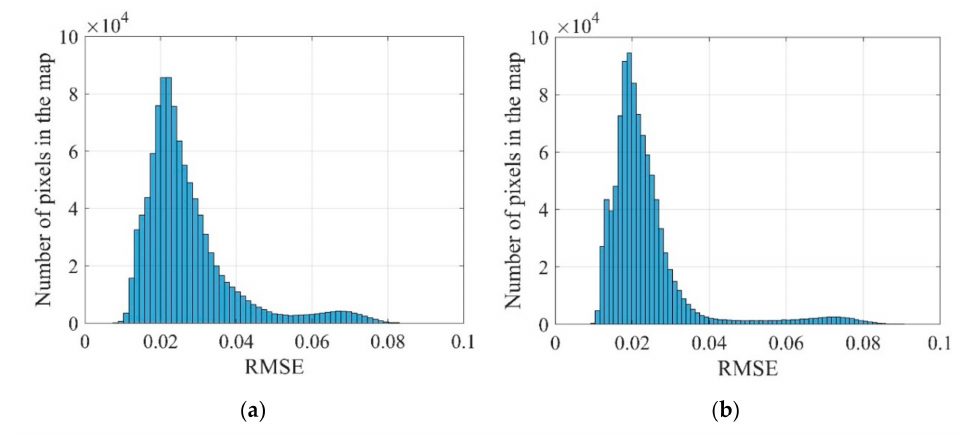
Figure 12. RMSE histogram using the HANTS algorithm ( a ) and the M-SSA algorithm ( b ).